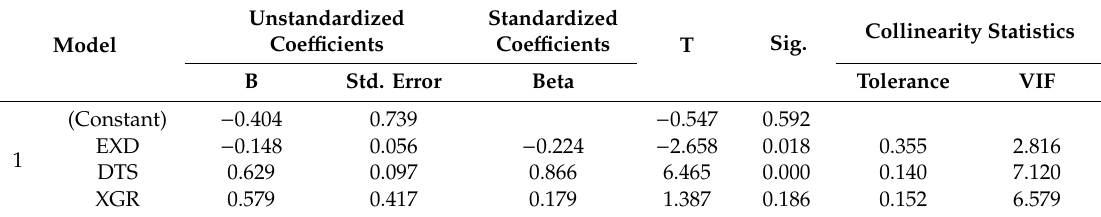
Table 3. Coe ffi